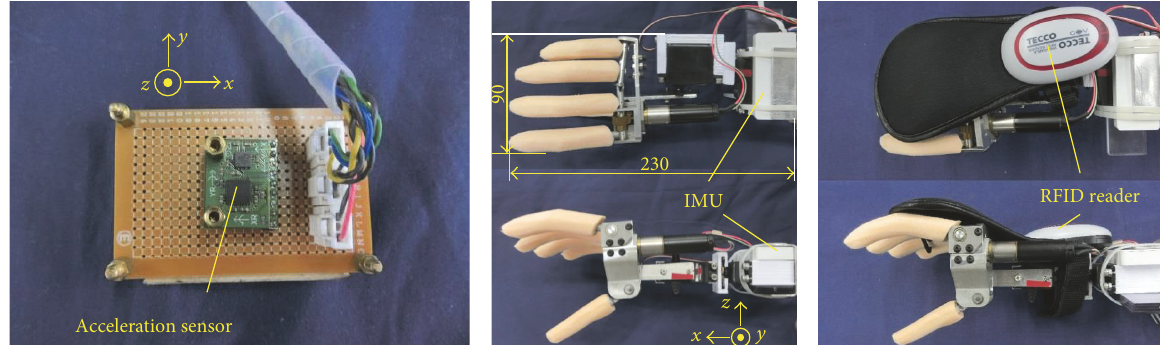
Figure 2: Hardware of system and sensor coordinate